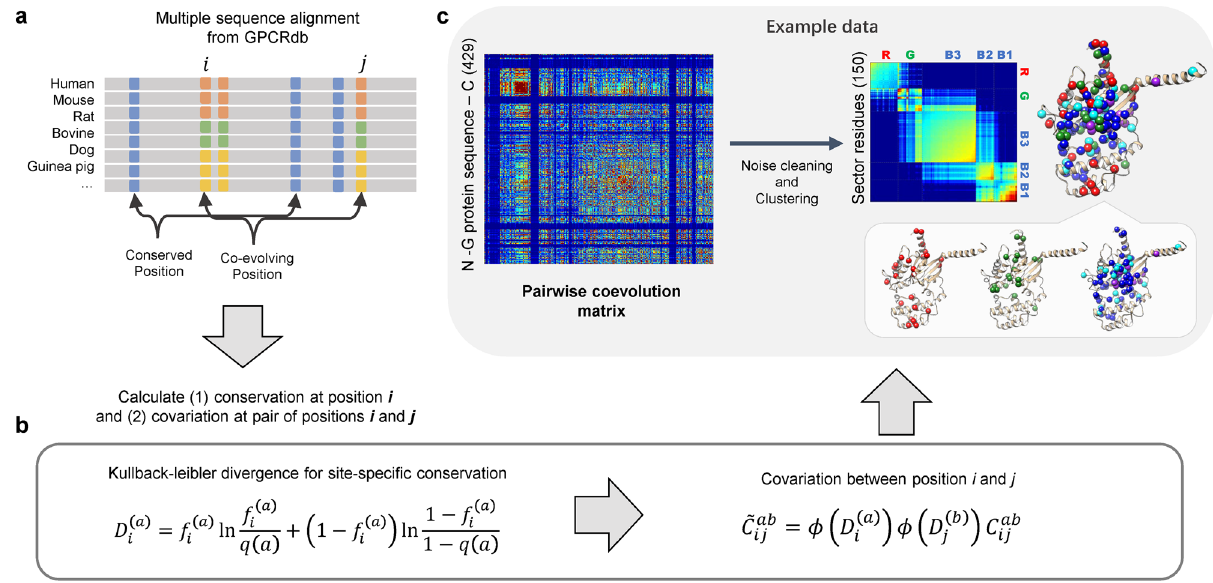
Figure 2. Overview of statistical coupling analysis (SCA). ( a ) Multiple sequence alignment is provided by GPCRdb (GPCRdb.org). ( b ) Calculation of Kullback–Leibler divergence for site-specific conservation and covariation between pairwise position. ( c ) Pairwise coevolution matrix is generated from ( b ). Then, through the noise cleaning and clustering process, sectors are GPCRs have coevolved sectors and a common conserved sector.